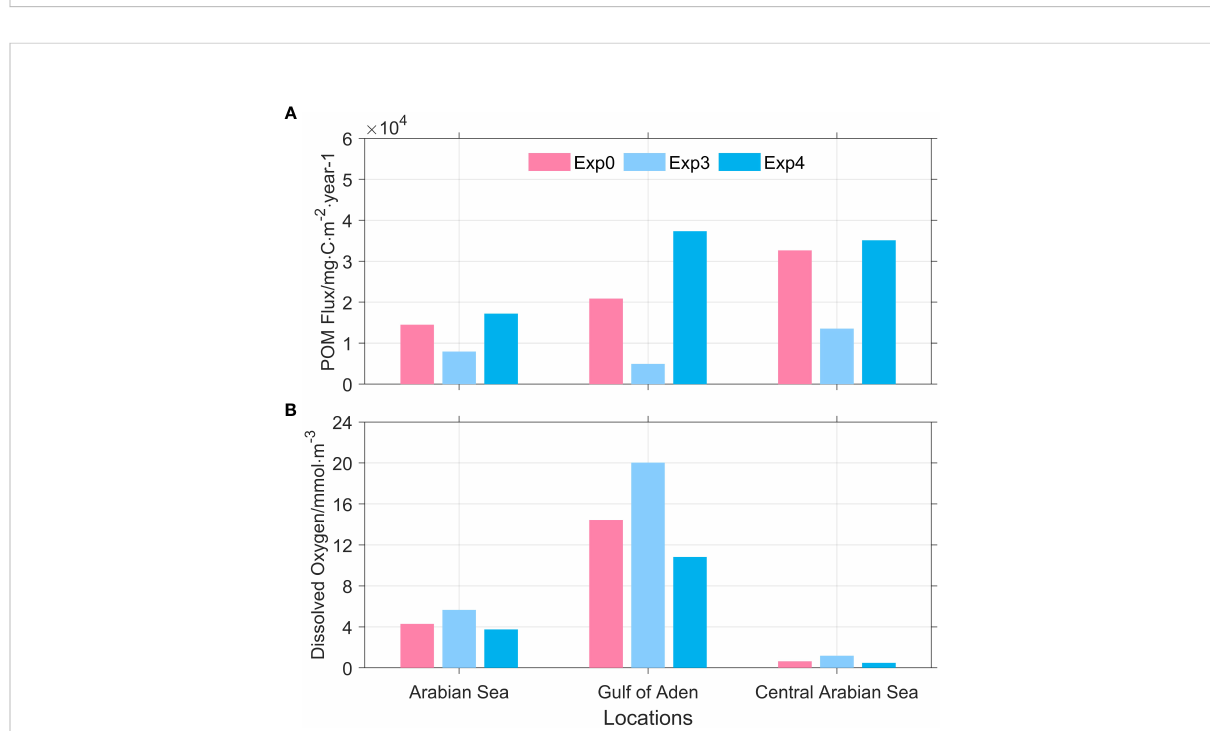
FIGURE 12 POM fl ux at 200 m (A) , dissolved oxygen average concentration ranging from 200 to 1,000 m (B) in the Arabian Sea (left column), site A (middle column; Gulf of Aden) and site B (right column; central Arabian Sea) from three experiments (Exp0, Exp3, and